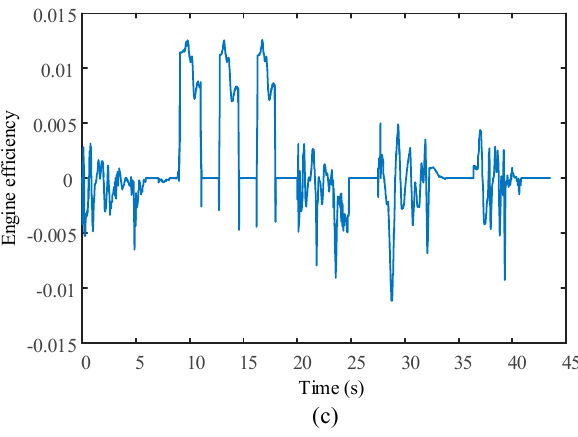
Figure 17. Difference between the solution c and the prototype TC. ( a ) Speed ratio; ( b ) Efficiency; ( c ) Engine efficiency.